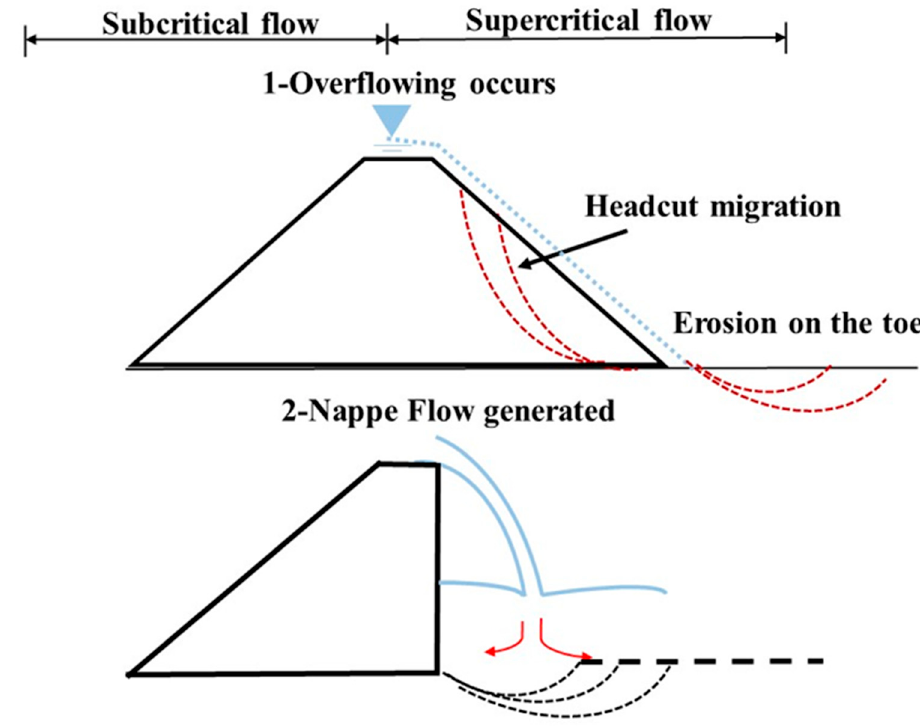
Figure 1. Stages of levee failure.